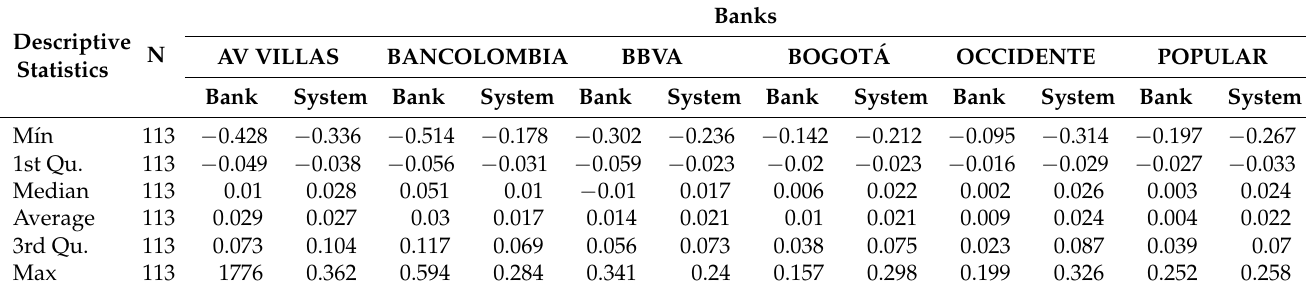
Table 1. Descriptive statistics of the market value growth rate of total assets and the system